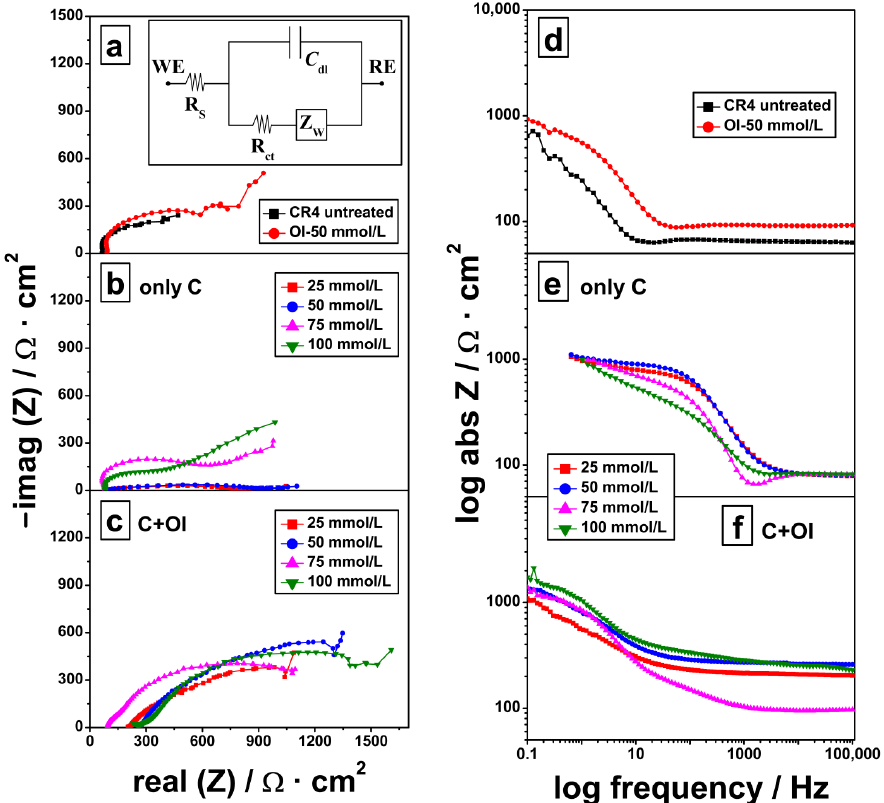
Figure 4. Left : EIS spectra with equivalent circuit (inset in a) of compounds C and OI: ( a ) for untreated CR4 steel (black squares) and OI at 50 mmol/L (red circles); ( b ) all concentrations (25–100 mmol/L according to the color code) for compound C; and ( c ) all concentrations for the combination C + O. Right : Bode plots of compounds C and OI: ( d ) for untreated CR4 (black squares) and OI at 50 mmol/L (red circles); ( e ) all concentrations (25–100 mmol/L according to the color code) for compound C; and ( f ) all concentrations for the combination C + O. (individual presentations in Supplementary SI